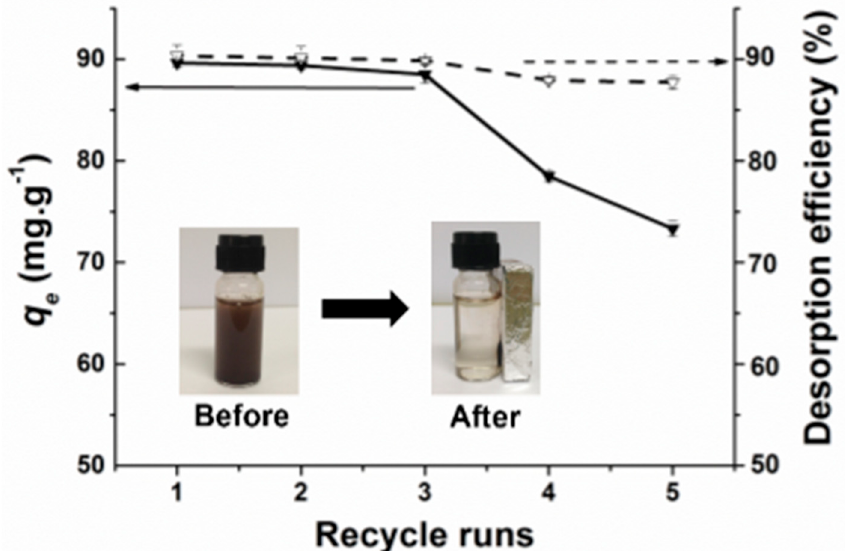
Figure 6. Hg ( II ) uptake ( solid line ) and percentage Hg ( II ) desorbed ( dashed line ) over five adsorption / desorption cycles using 500Cys - C@Fe 3 O 4 sorbent . The inset shows the separation of